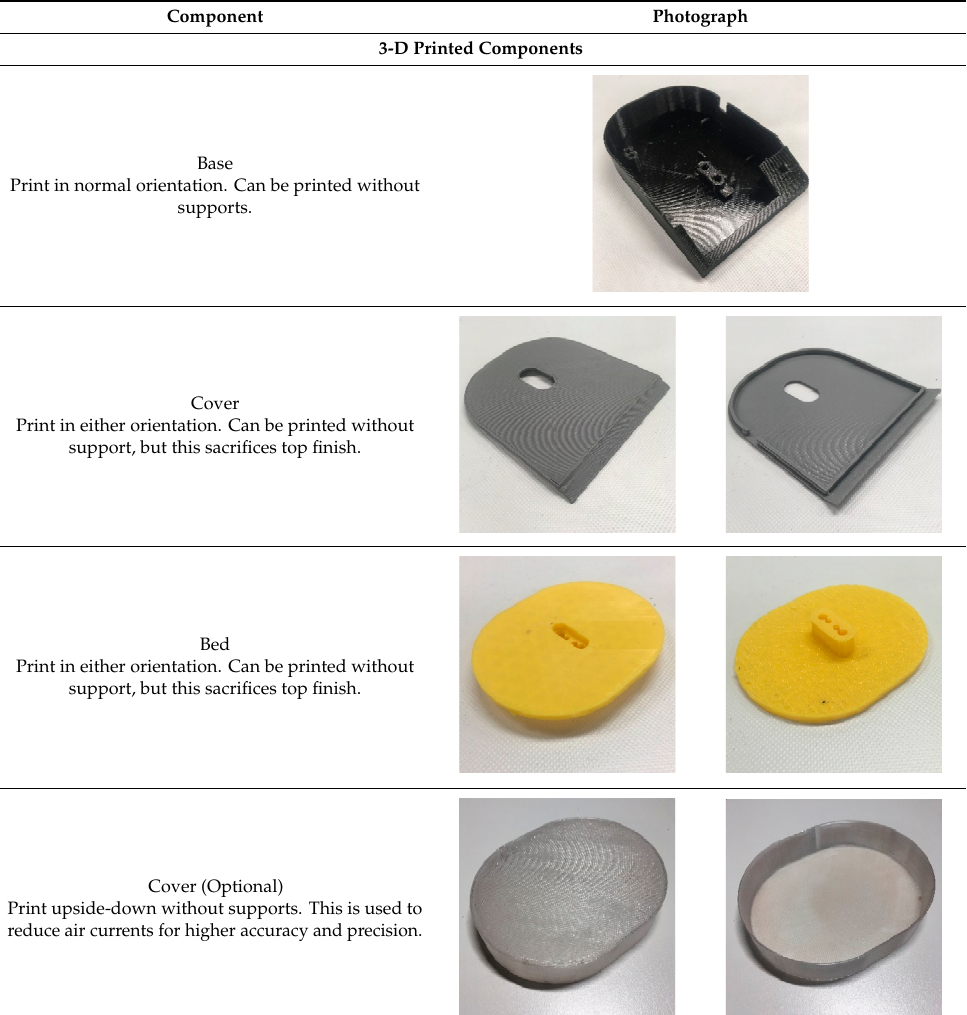
Table 1. Visual bill of materials separated by mechanical and electrical components.